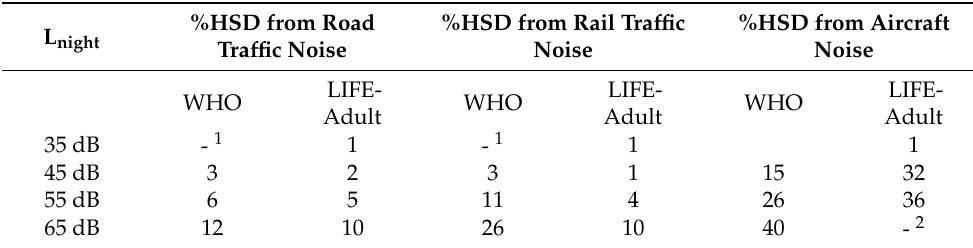
Table 2. Example for %HSD from road traffic, rail traffic and aircraft noise for the LIFE-Adult study and the WHO Environmental Noise Guidelines for the European Region: A Systematic Review on Environmental Noise and Effects on sleep [14]. %HSD from Road %HSD from Rail Traffic L night Traffic Noise